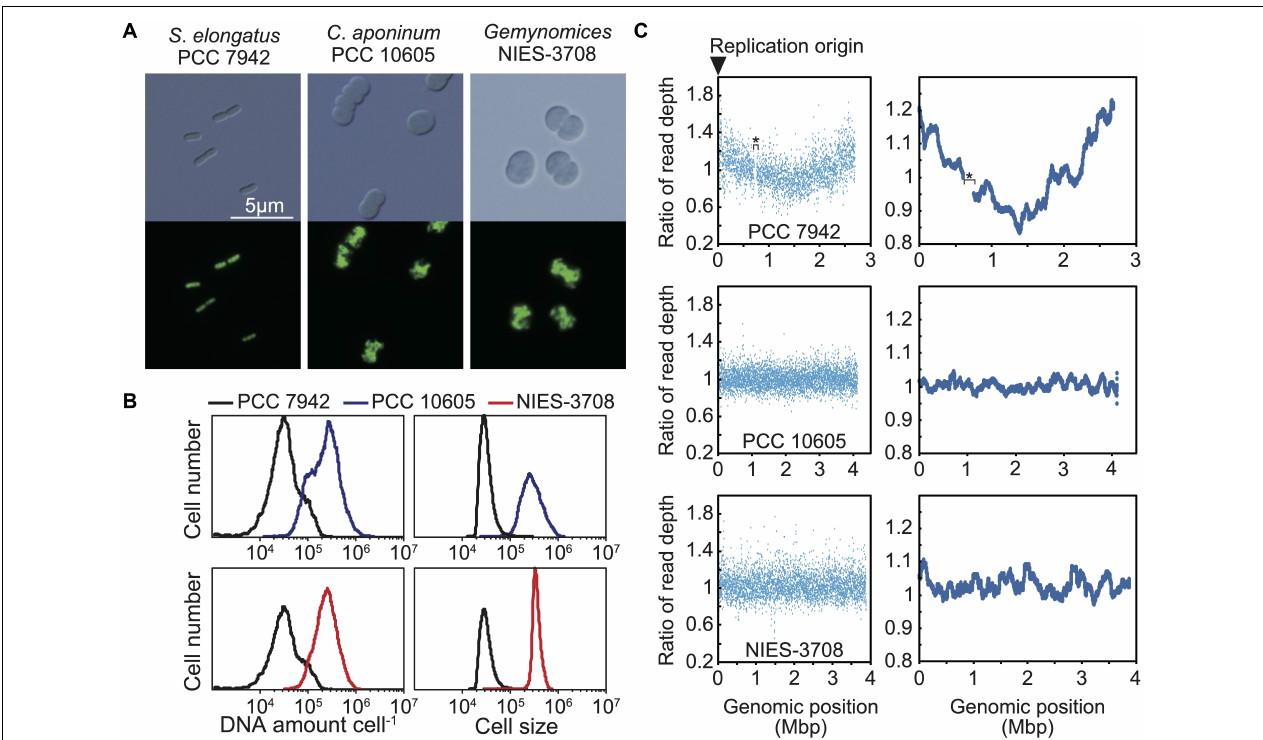
FIGURE 2 | Ploidy and replication manner of the chromosomes of C. aponinum PCC 10605 and Geminocystis sp. NIES-3708. Exponentially growing C. aponinum (chromosome approximately 4.1 Mbp), Geminocystis sp. (chromosome approximately 3.9 Mbp), and S. elongatus (chromosome approximately 2.7 Mbp; 3–6 copies per cell; Zheng and O’Shea, 2017) ( Supplementary Figure S2 ) were fixed and stained with SYBR Green and then examined using flow cytometry. (A) Images of SYBR Green-stained cells. Images were acquired using differential interference contrast microscopy (top) and fluorescence microscopy (bottom). (B) Distribution of DNA levels per cell and cell volumes of exponentially growing cultures of C. aponinum (blue), Geminocystis sp. (red), and S . elongatus (black). (C) Depths of the high-throughput genomic DNA sequence reads at their respective chromosomal regions. Genomic DNA was extracted from the exponentially growing cells ( Supplementary Figure S2 ) and analyzed using an Illumina MiSeq System. Plots of 1-kb (left) and 100-kb windows (right). The number of reads (divided by the number of total reads) of the growing (replicating) cells normalized by that of the stationary phase (non-replicating) cells at each genomic position is shown. The asterisk in the profile of S. elongatus indicates a ∼ 50-kb genomic deletion in our wild type strain which has little effect on replication and cellular growth (Watanabe et al.,